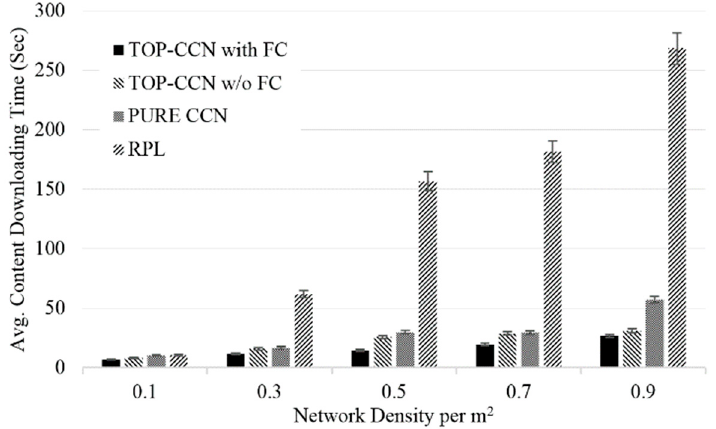
Figure 12. Average content downloading time of the BestEffort applications.